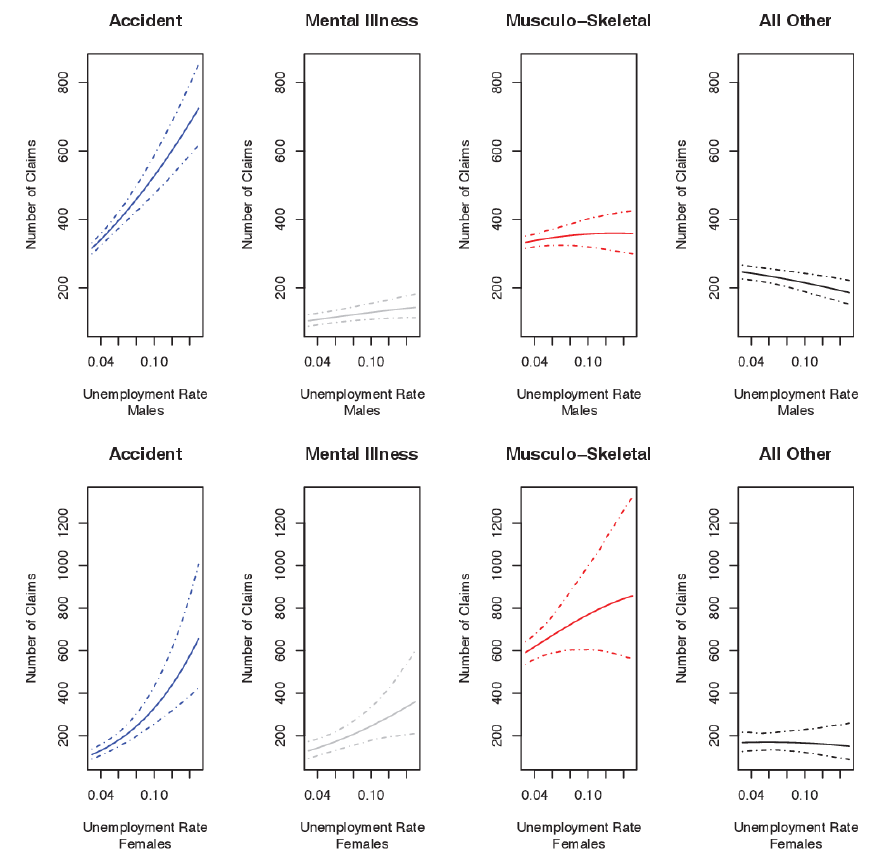
Figure 5. Insured population combined model: number of claims by cause at each level of unemployment rate